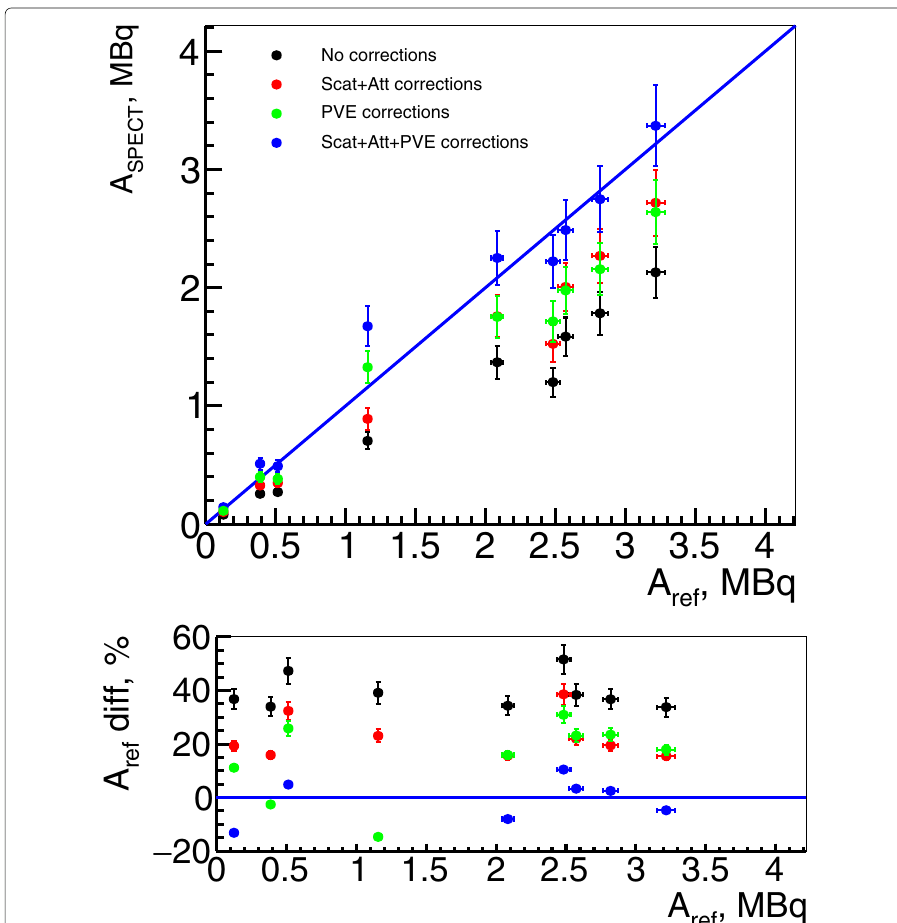
Fig. 6 Activity from SPECT images in in vivo studies (kidneys). In vivo 111 In activity measurements on right kidneys from uncorrected images in black, from images with only attenuation correction in red, with only PVE corrections in green and with all corrections in